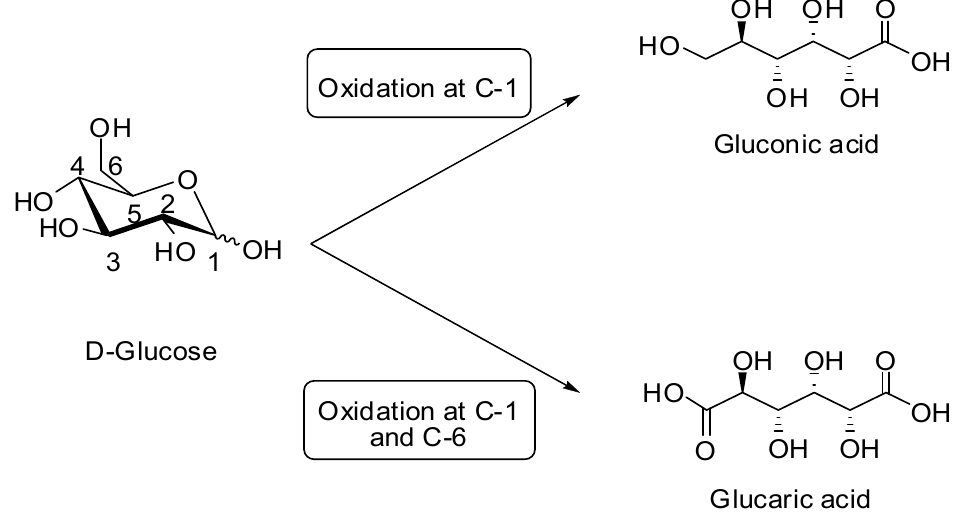
Scheme 1. Oxidation of glucose into corresponding gluconic and glucaric acids.